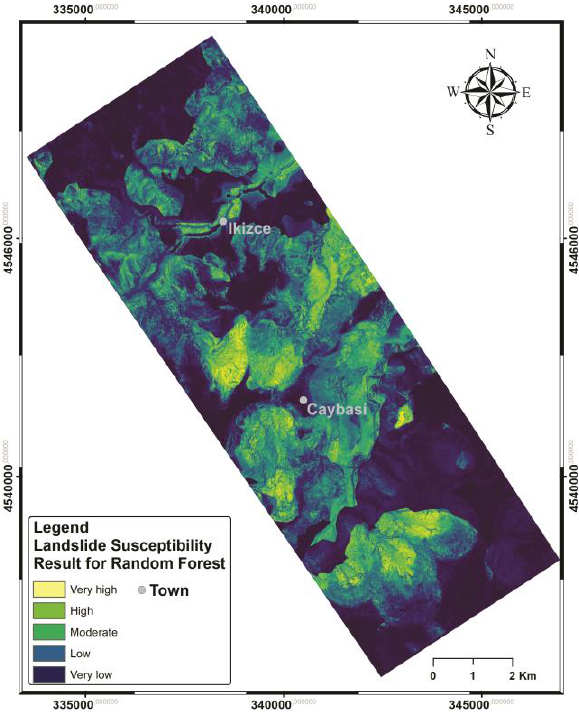
Figure 13. Landslide susceptibility map of the study